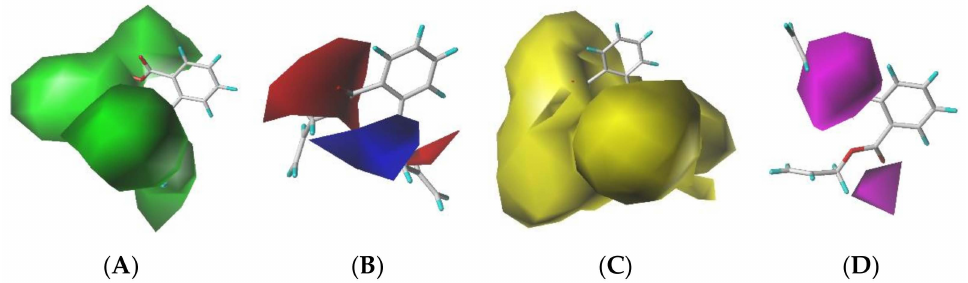
Figure 1. Three-dimensional contour maps of ( A ) steric, ( B ) electrostatic, ( C ) hydrophobic, and ( D ) hydrogen bond acceptor fields.